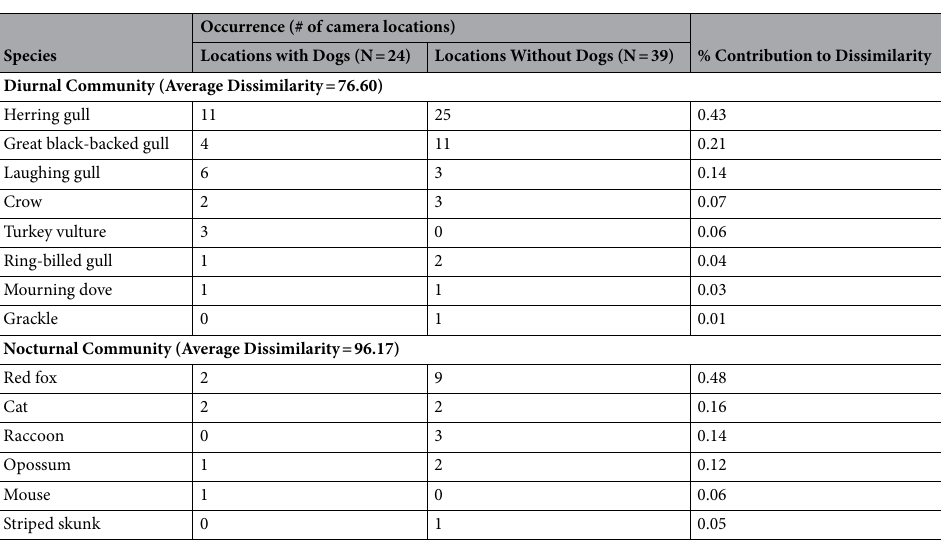
Table 1. Frequency of occurrence of scavenger species at camera locations where dogs were and were not observed along ocean-exposed beaches in New Jersey, USA. Results of the SIMPER analysis are presented as the percent contribution to dissimilarity between observed communities with and without